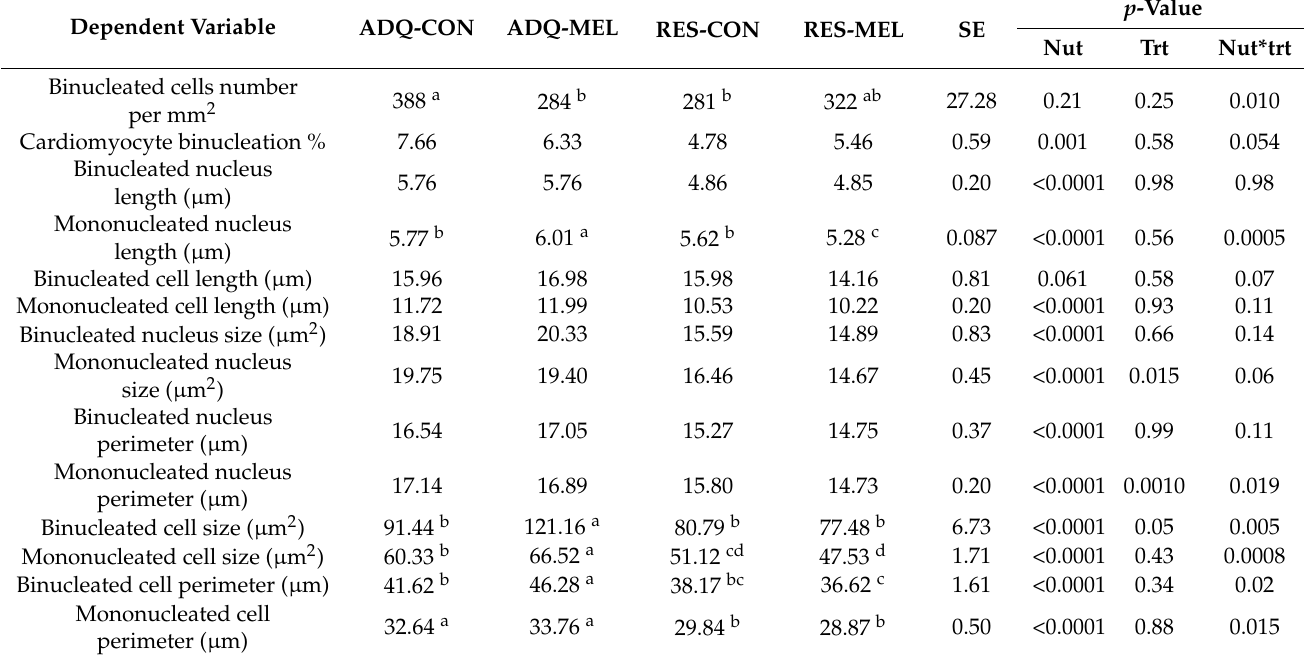
Table 3. Cardiomyocyte characteristics of 8-month-old fetuses. Different letter superscripts (a–d) represent significant differences ( p < 0.05) between the nutritional plane and treatment